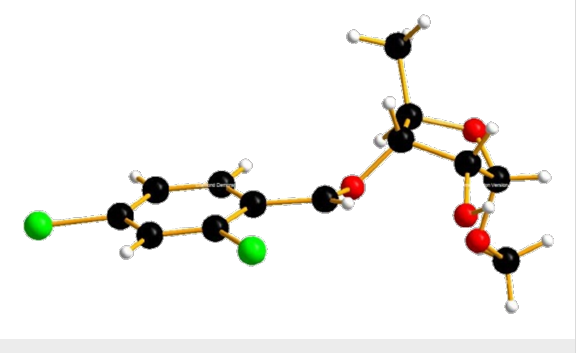
Figure 3: The X-ray crystal structural of 1- O -methyl-3- O -(2,4- dichlorobenzyl)-5-deoxy- α -D-ribofuranose ( 9 ).